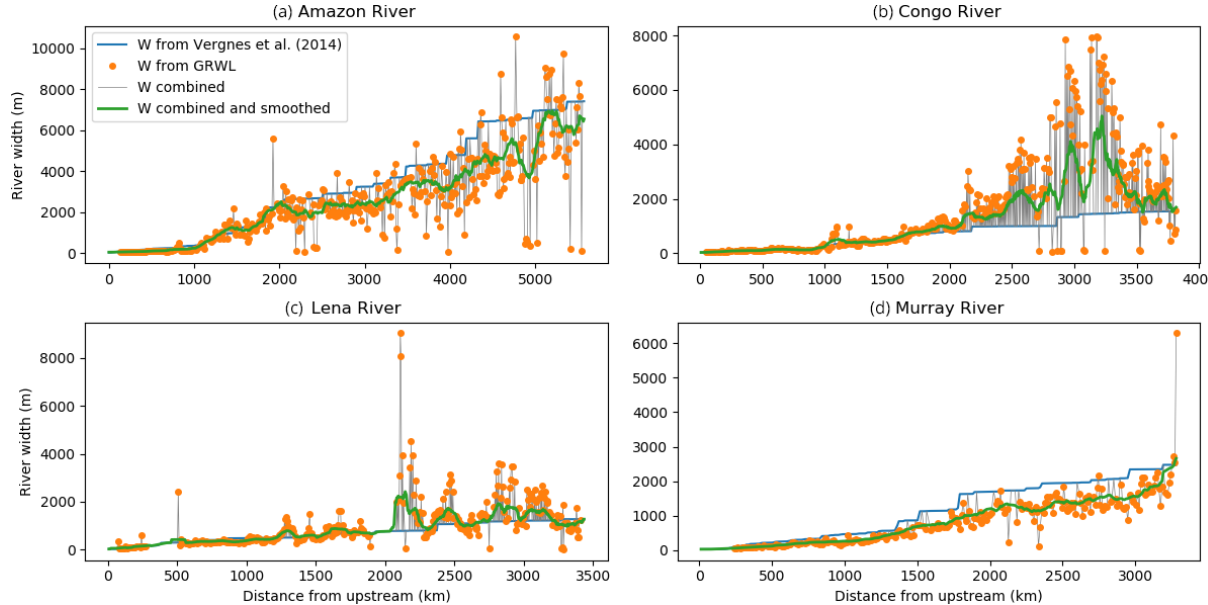
Figure 11. Examples of the combination of river widths from GRWL and Eq. (2) for (a) the Amazon River, (b) the Congo River, (c) the Lena River and (d) the Murray River.